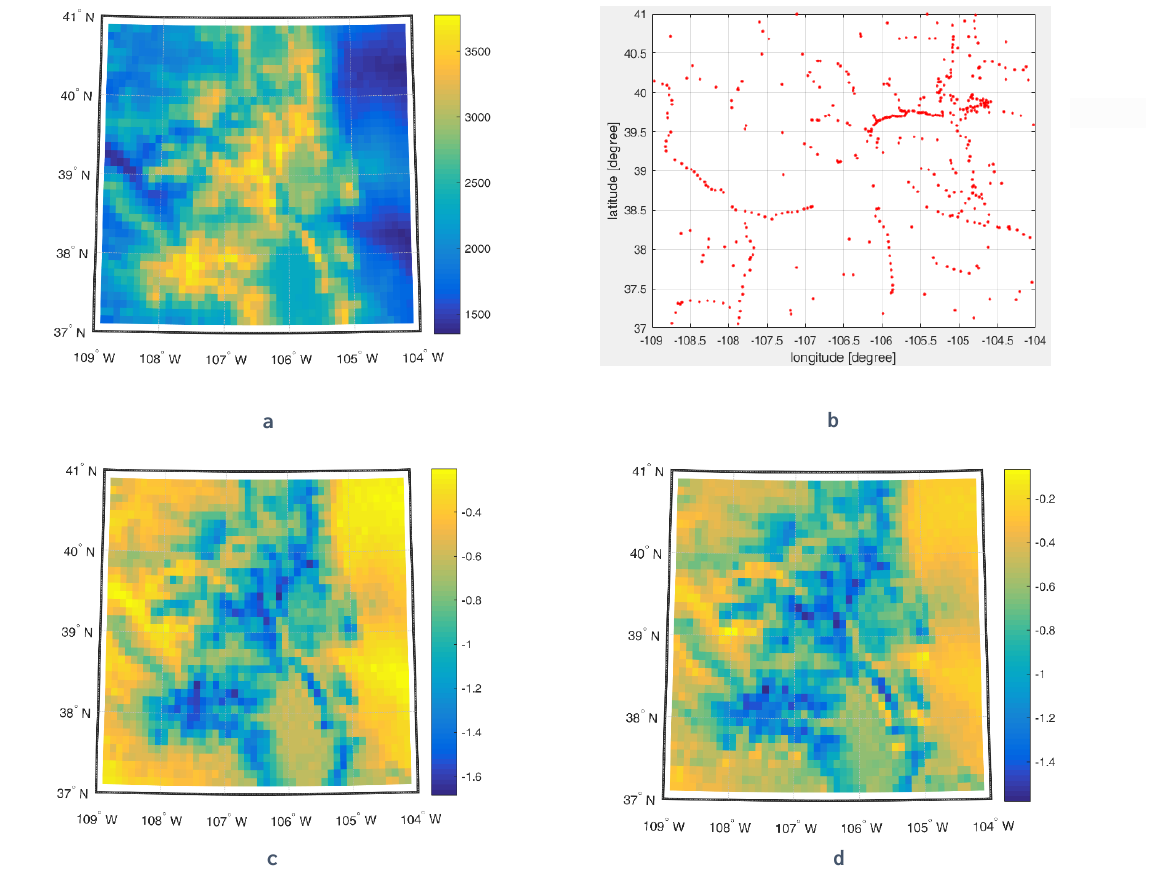
Figure 1 . (a) the topographic of test area, unit: meter, (b) GNSS-Levelling stations location in test area, (c) the total topographic effect on the GQS, unit: meter and (d) separation between the geoid to quasigeoid as a result of the direct method, unit: